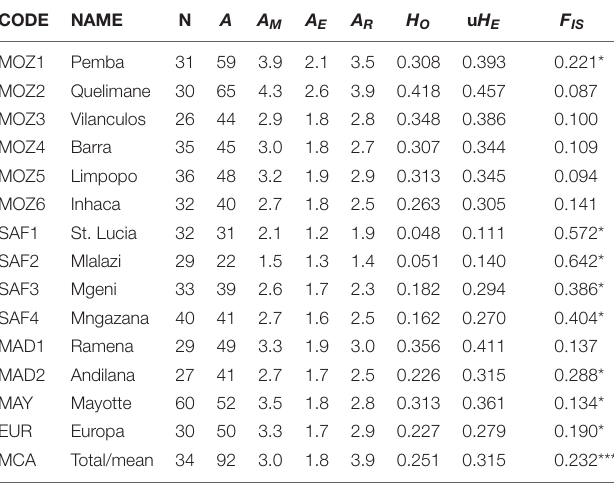
TABLE 2 | Population genetic variables of 14 Avicennia marina populations in the Western Indian Ocean region and used for fine-scale genetic structure analysis.